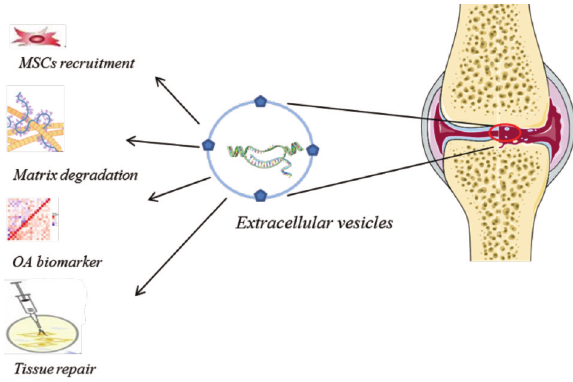
Extracellular vesicles (EVs) in osteoarthritis. EVs released Fig. 1: from synovial joint play several roles. EVs are involved in MSCs recruitment and tissue repair, tissue destruction and matrix degradation. EVs are thought to be potential tool for tissue repair and can be utilised as tissue